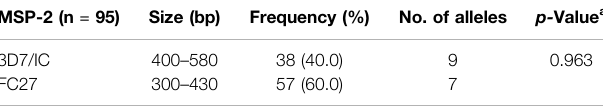
TABLE 2| Genotypingof Plasmodiumfalciparummsp-2 inKhyber